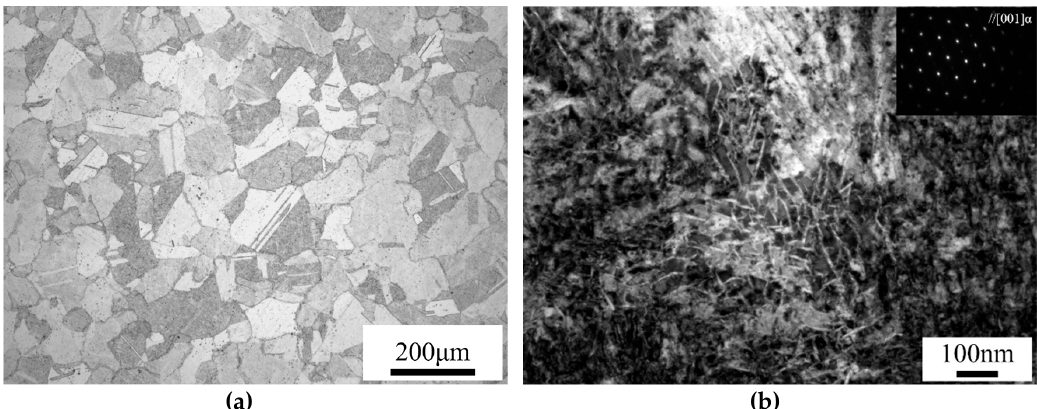
Figure 5. Microstructural analysis of the base metal: ( a ) optical microscopy, ( b ) transmission electron microscopy.